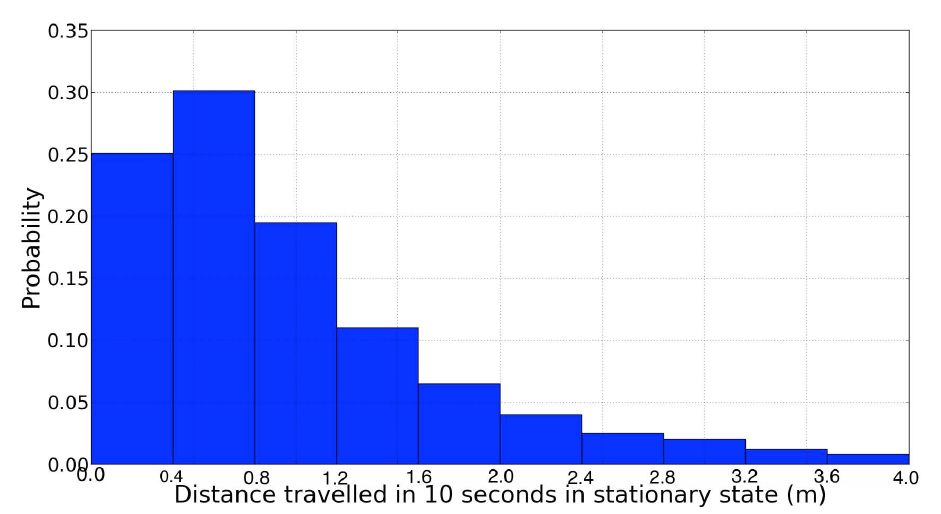
Figure 10. Distribution of travelled distance in a 10 s time window by all nodes in stationary mode.